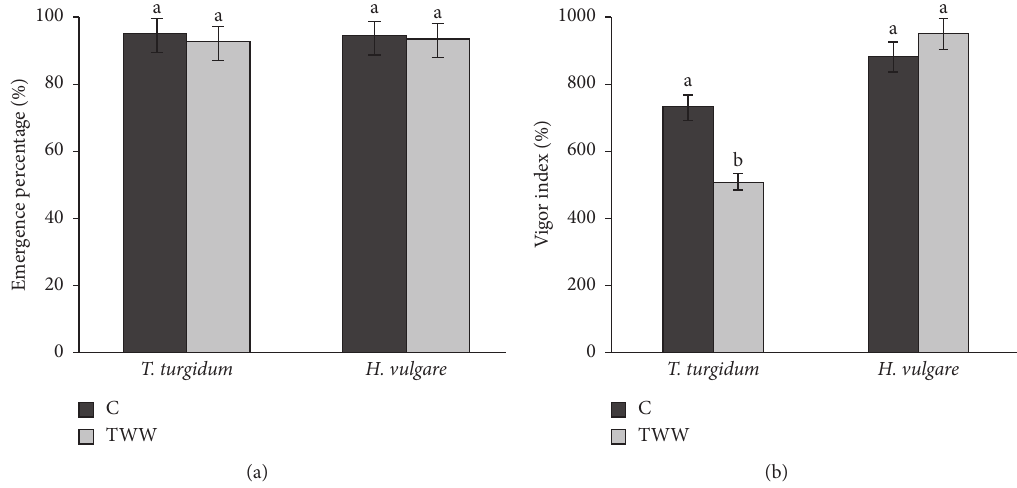
Figure 2: Emergence percentage and vigor index of T. turgidum and H. vulgare leaves cultured in control soils and wastewater irrigated soils. Means of four replicates. Bars marked with the same letter are not significantly different at p < 0 . 05.